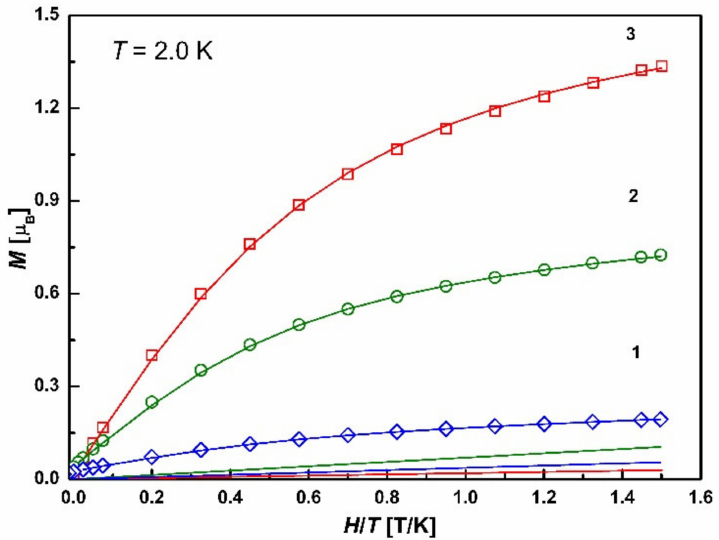
Figure 14. The field dependences of the magnetization, M , measured at T = 2.0 K for 1 ( ♦ ), 2 (o), and 3 ( (cid:3) ). Solid lines are the best fit curves corresponding to a superposition of linear function (straight lines) and weighted Brillouin functions for S = 5/2 and S = 1/2 (see main text for